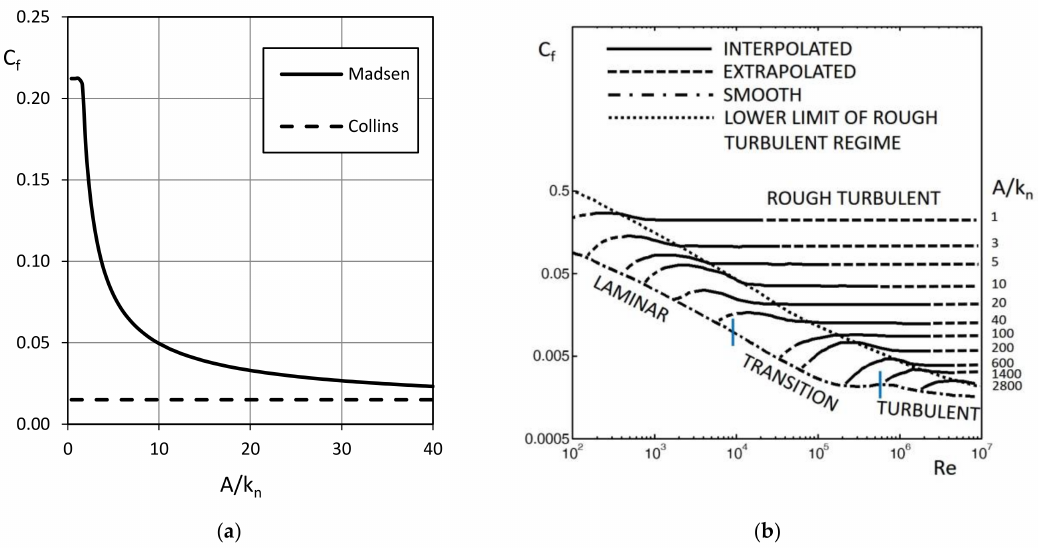
Figure 10. ( a ) Comparison between the constant value of the bottom friction coefficient C f assumed by Collins [37] and that computed by Madsen et al. [38] as a function of the relative roughness A/k n ; ( b ) friction coefficient diagrams proposed after Kamphuis